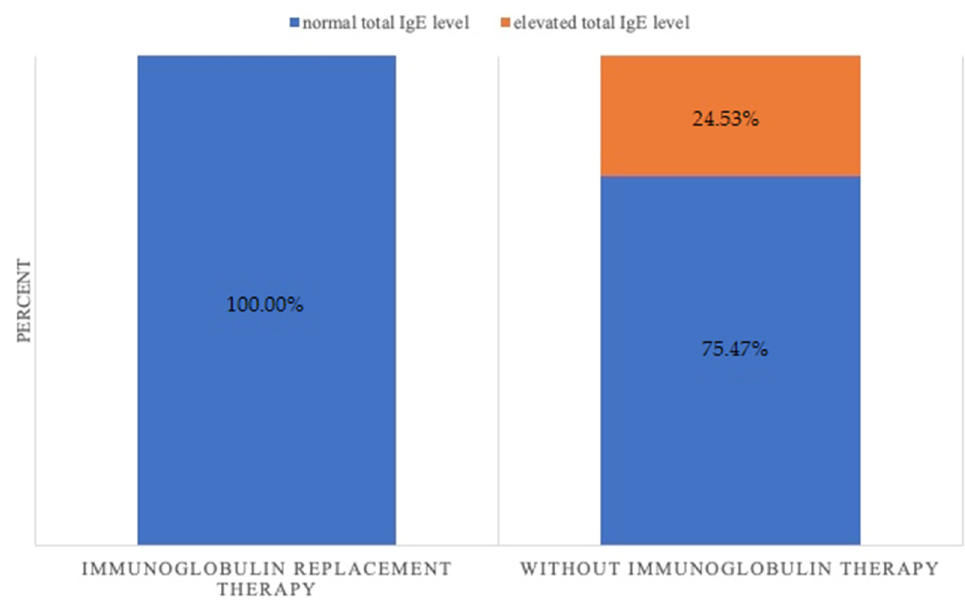
Figure 3. Total IgE level in relation to immunoglobulin replacement therapy ( p = 0.04).